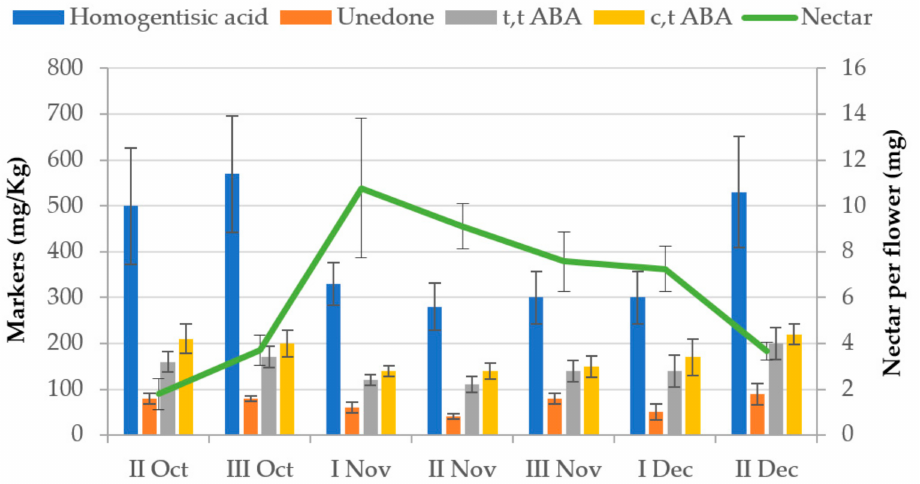
Figure 6. Concentration (mg/kg ± SE) of different markers (HGA—Homogentisic Acid; Unedone; t,t ABA—( ± )-2-trans,4-trans-abscisic acid, t,t ABA; c,t ABA—( ± )-2-cis,4-trans-abscisic acid); in nectar of strawberry tree ( Arbutus unedo L.), flowers, and trends (means among different stations ± SE) of nectar secretion during the flowering period (decades)